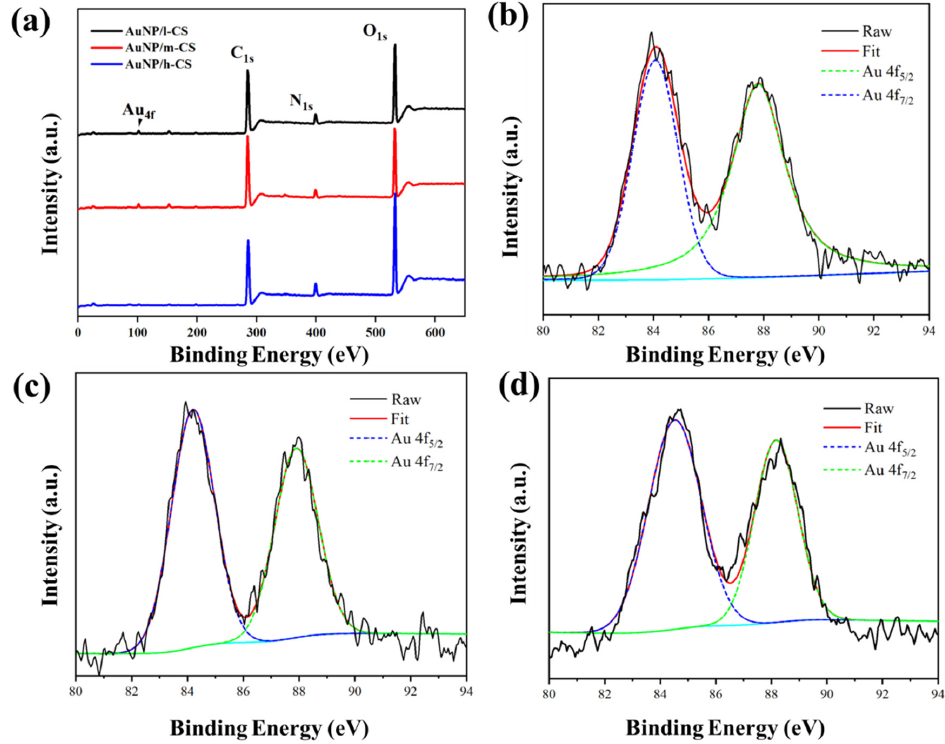
Figure 3. ( a ) Survey XPS spectra of 0.5 mM AuNP/l-CS, 0.5 mM AuNP/m-CS, and 0.5 mM AuNP/h- CS nanocomposites. ( b – d ) Au 4f core XPS spectrum of 0.5 mM AuNP/l-CS, 0.5 mM AuNP/m-CS, and 0.5 mM AuNP/h-CS nanocomposites, respectively.